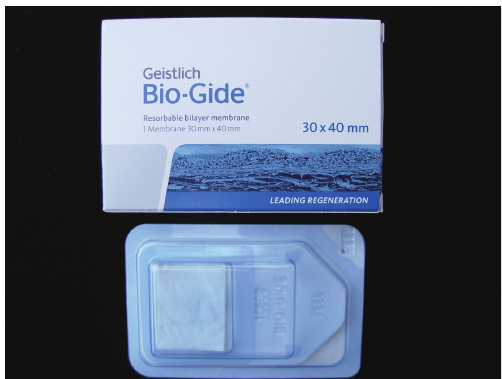
Figure 2: Xenogenous (porcine origin) barrier membrane used in the study.